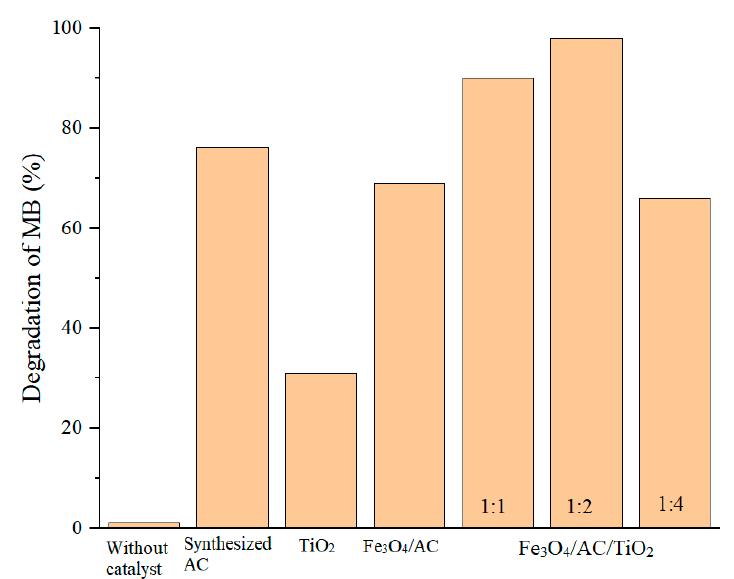
Figure 8 . Photocatalytic degradation of MB for pure TiO 2 , synthesised AC, Fe 3 O 4 /AC, and Figure 8.